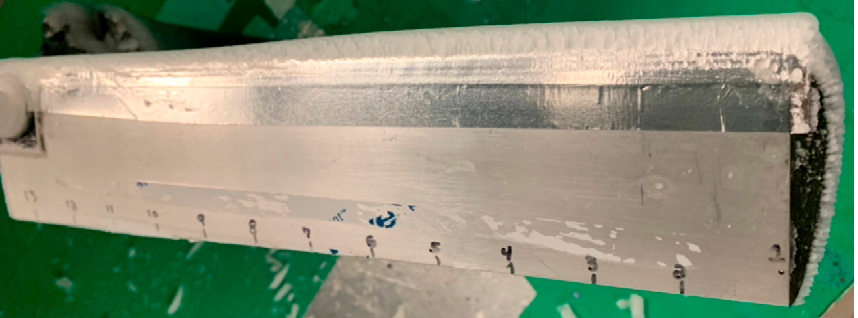
Figure 15. Mixed ice accumulation, a combination of clear and rime ice, on aluminum during de-icing tests at − 15 °C.